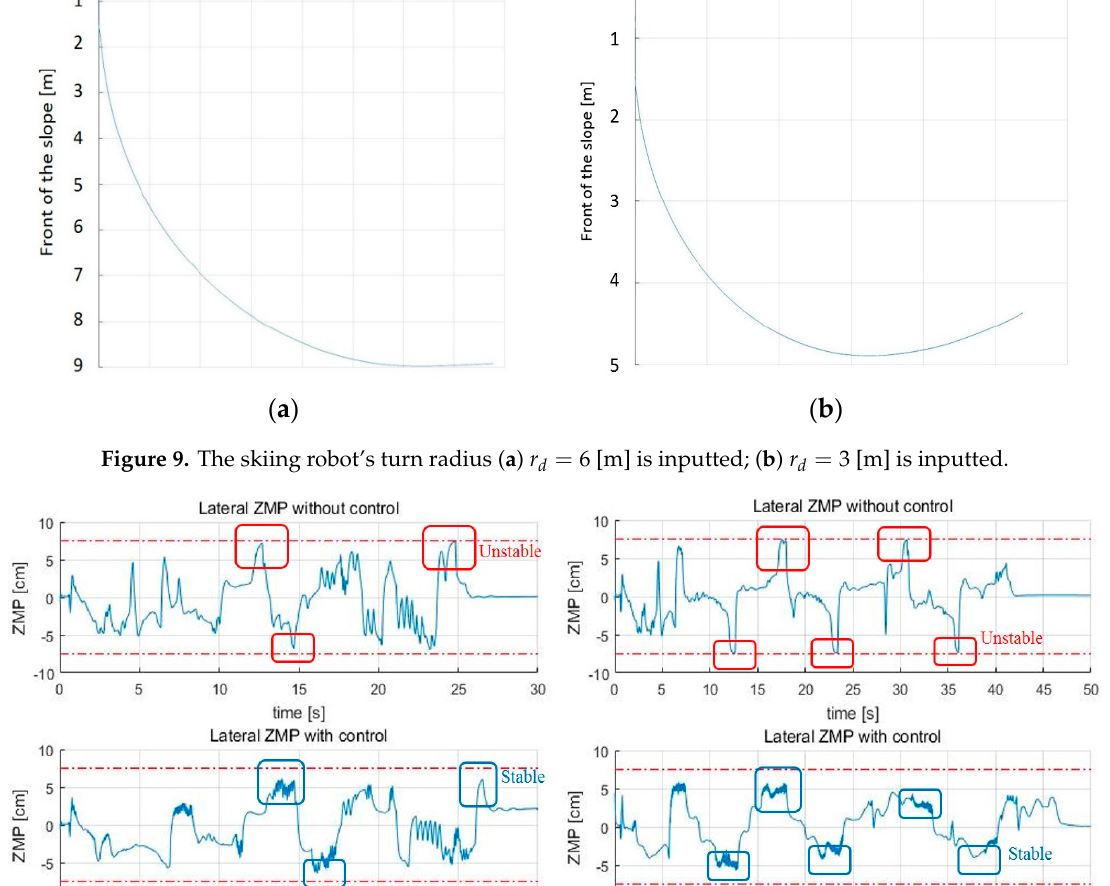
Figure 10. The results of the ZMP control ( a ) Short interval; ( b ) Long interval.